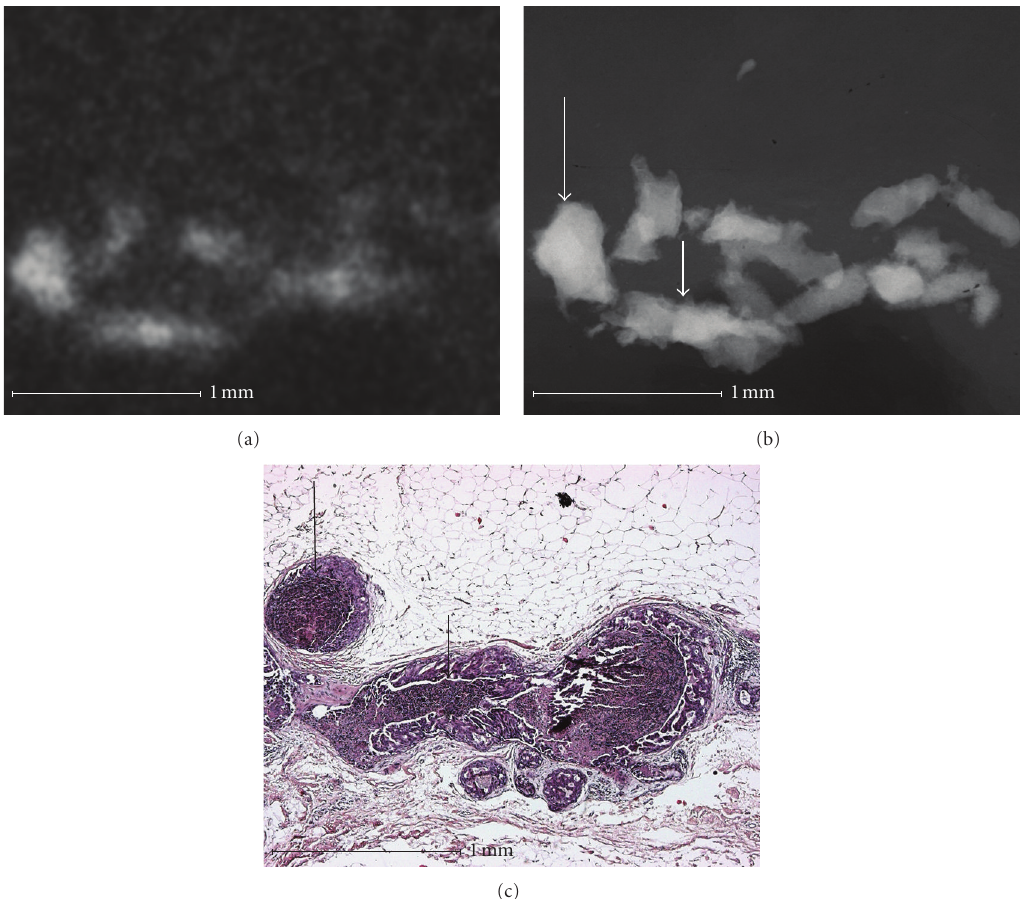
Figure 2: Intraductal comedo type breast carcinoma (high grade). Microradiography shows fine linear calcifications with smooth borders (large arrow in (b)) in which the calcified tumor necrosis completely fills the duct (large arrow in (c)). Linear calcifications with rough, irregular borders are also shown (small arrow in (b)). In these areas the calcifications are not significantly progressed and they do not completely fill the duct (small arrow in (c)). These microradiographic di ff erences are not detectable in conventional specimen radiography